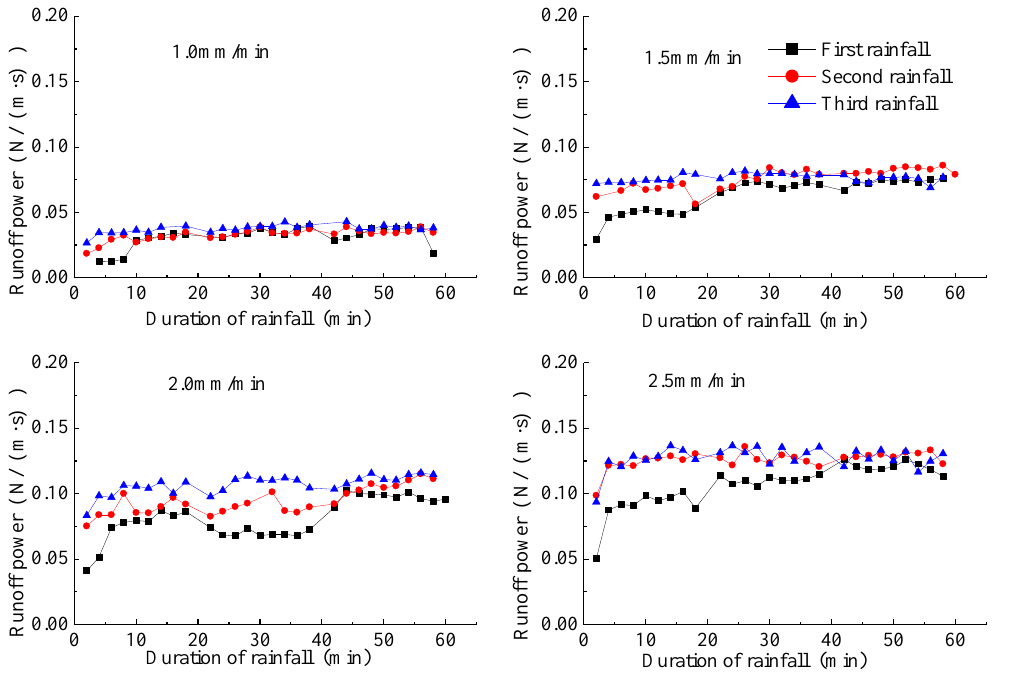
Figure 20. Variation curve of runoff power with time of the loess slope.